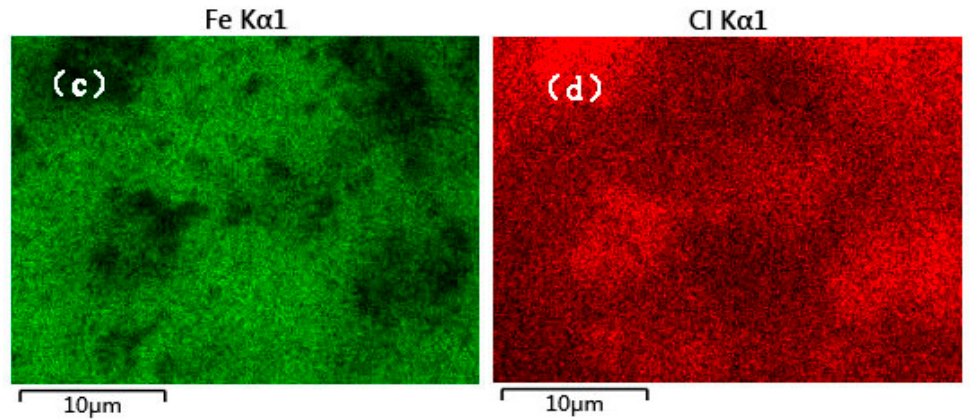
Figure 5. SEM image of Ag / AgCl / MIL-101(Fe) ( a ), SEM-EDX elemental mappings of Ag ( b ), Fe ( c ) and Cl ( d ).